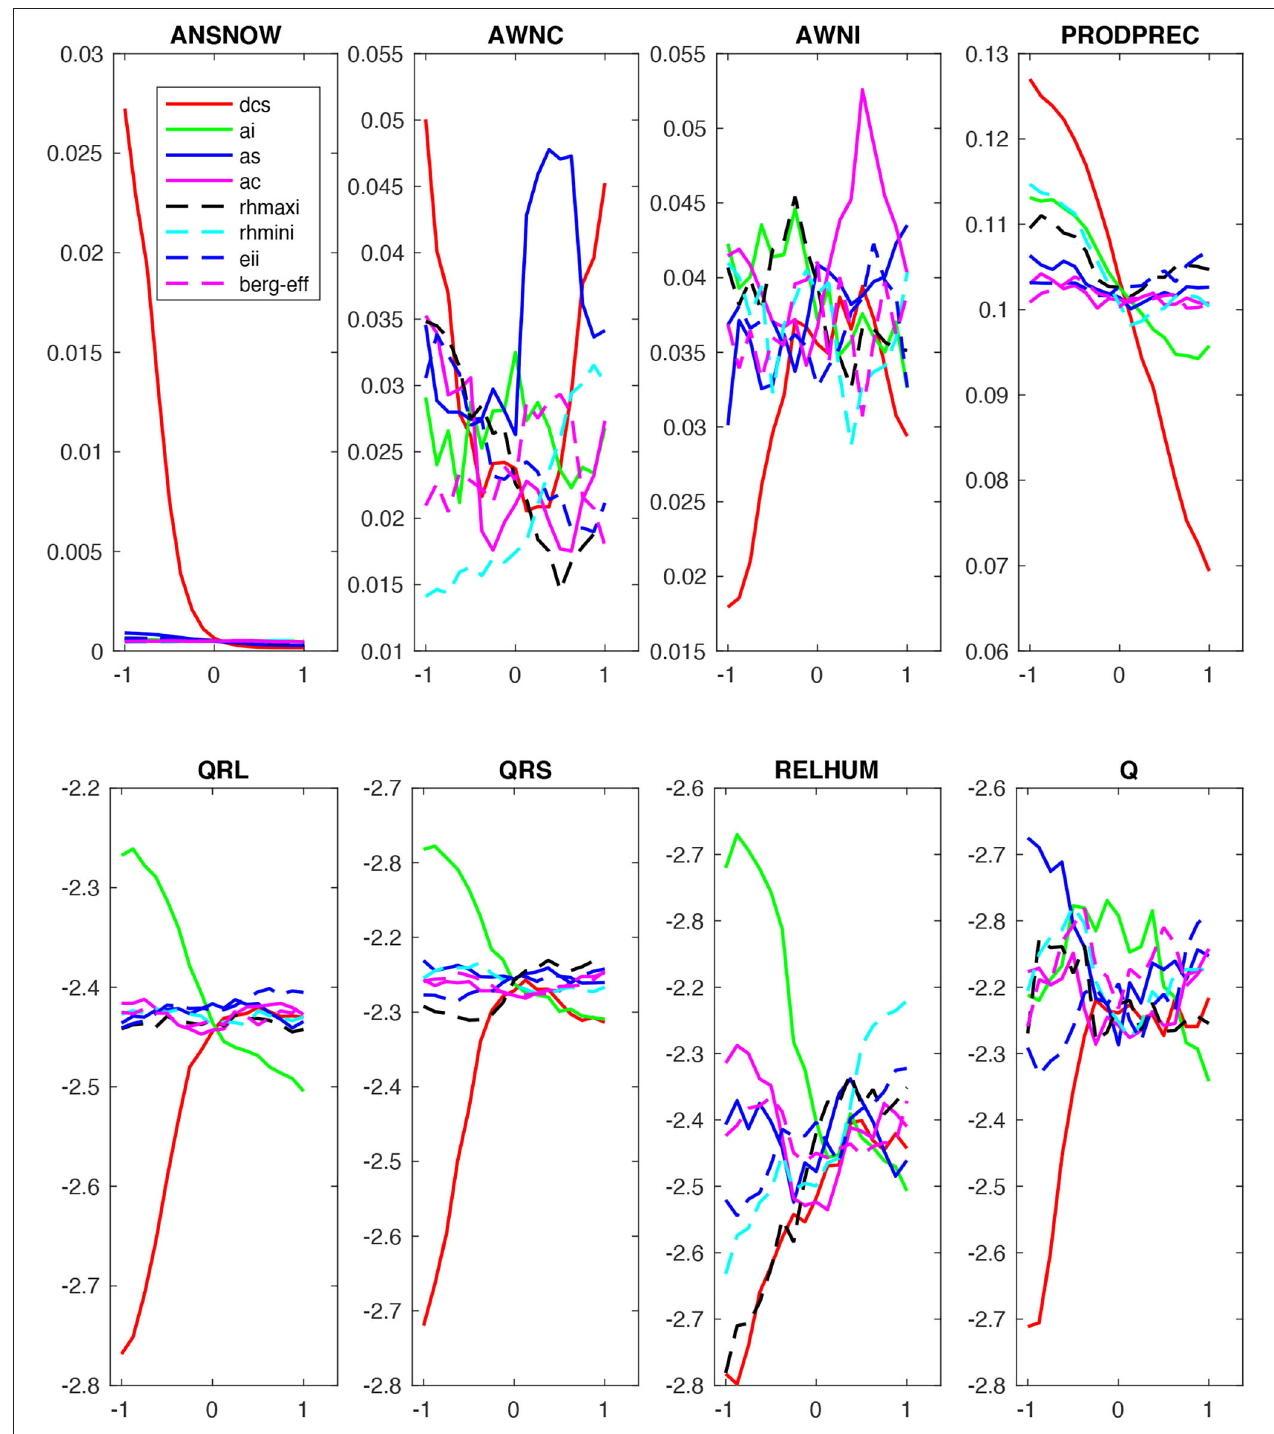
FIGURE 11 | Parameter perturbation responses to vertically averaged (surface to 100 hPa) variables (ANSNOW, AWNC, AWNI, PRODPREC, QRL, QRS, RELHUM, and Q).